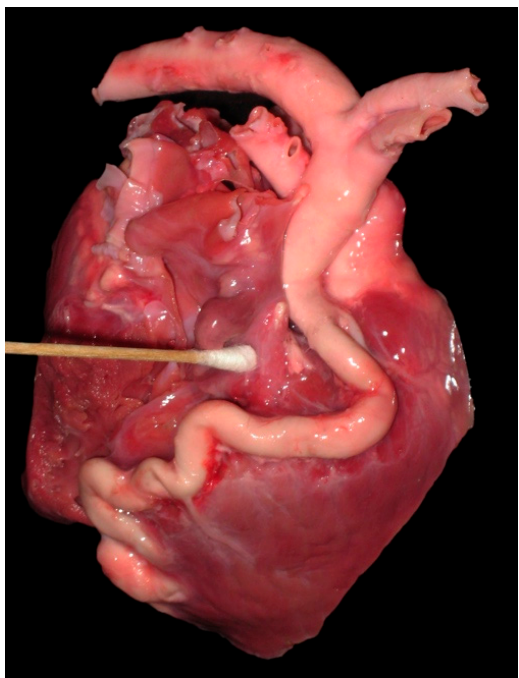
Figure 9. Photograph of the heart from a 6-day-old llama cria showing a severely dilated and tortuous right coronary artery fistula, which drained to the proximal right ventricle.